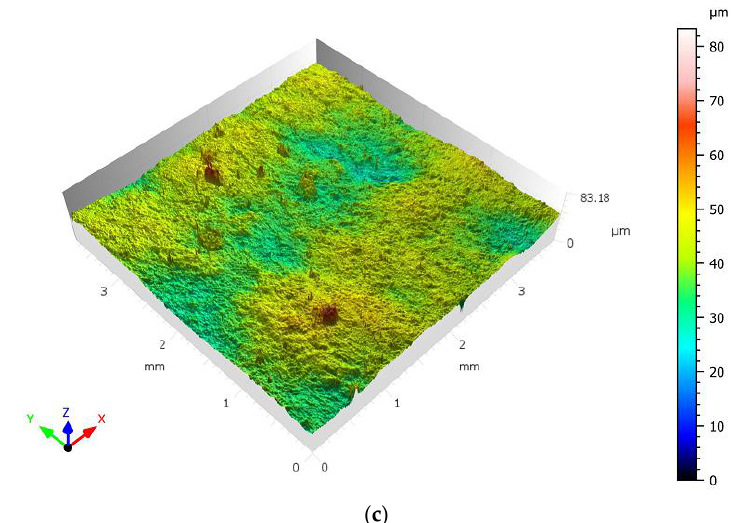
Figure 12. Polished specimen B ’ and surface morphology of area B ’ . ( a ) SEM images of Part B ’ ; ( b ) Polished specimen B ’ ; ( c ) 3D profiles of B ’ .